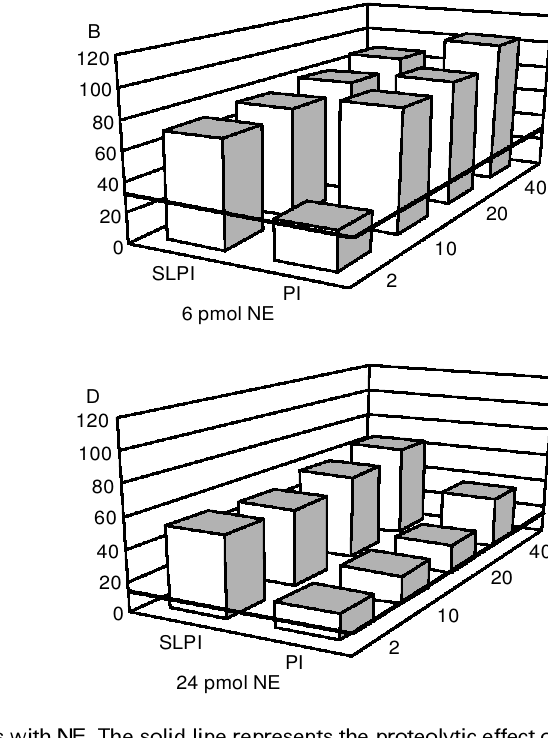
FIG. 2. The effect of incubation of endothelial matrix-coated wells with NE. The solid line represents the proteolytic effect of NE alone, while the bars represent NE in the presence of SLPI or PI.